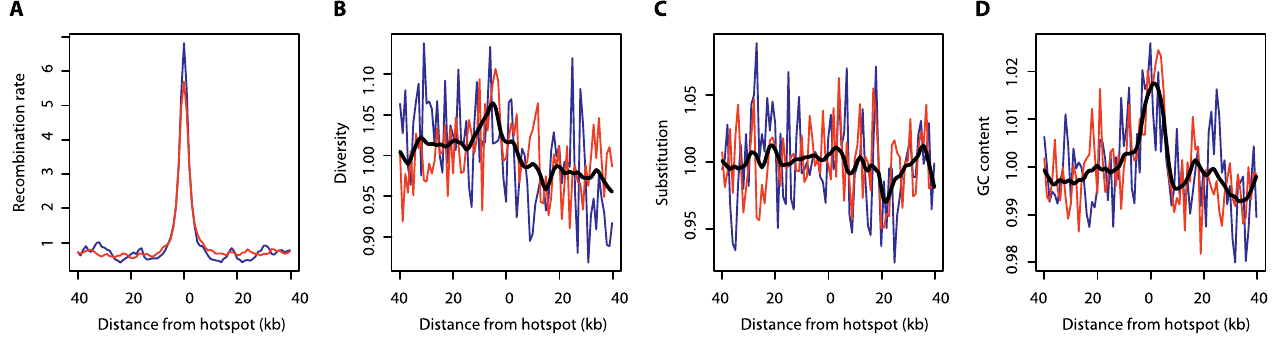
Figure 6. Effects of Recombination Hotspots on Genomic Features (A) The elevation of relative recombination rate around defined hotspots on the short (blue) and long (red) arms of Chromosome 20. (B) Elevation of relative diversity around hotspots (the black line is a smoothed average of the two arms). (C) There is no effect of hotspots on relative divergence. (D) Hotspots are associated with local increases in relative GC content. Note that a relative scale was used because the long and short arms can